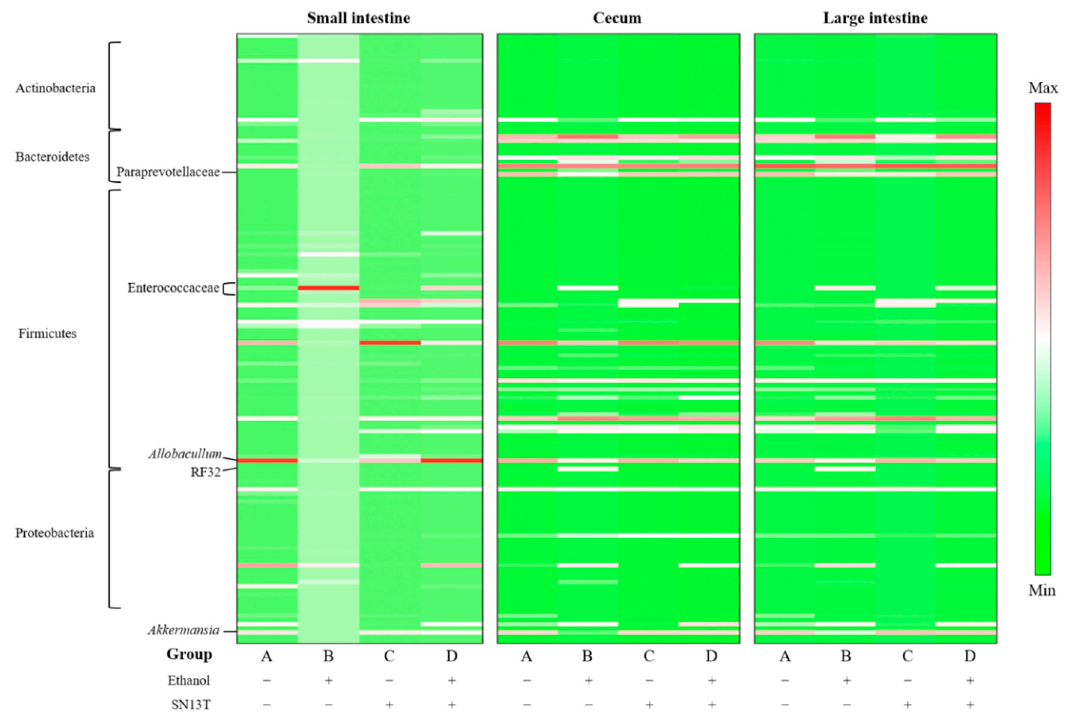
Figure 3. The microbiota in the small intestine, cecum, and large intestine collected from C57BL/6J mice. Prior to the administration of ethanol, the mice were kept for one week using the L10015 diet supplemented with (groups C and D) or without (groups A and B) live SN13T cells. After one week, the L10015 diet was changed to an L10016 diet in groups B and D. The intestinal bacteria were determined using the V3–V4 region in 16S rDNA and indicated by the standardized relative abundance ratio. Denser green and red indicate lower and higher amounts, respectively.